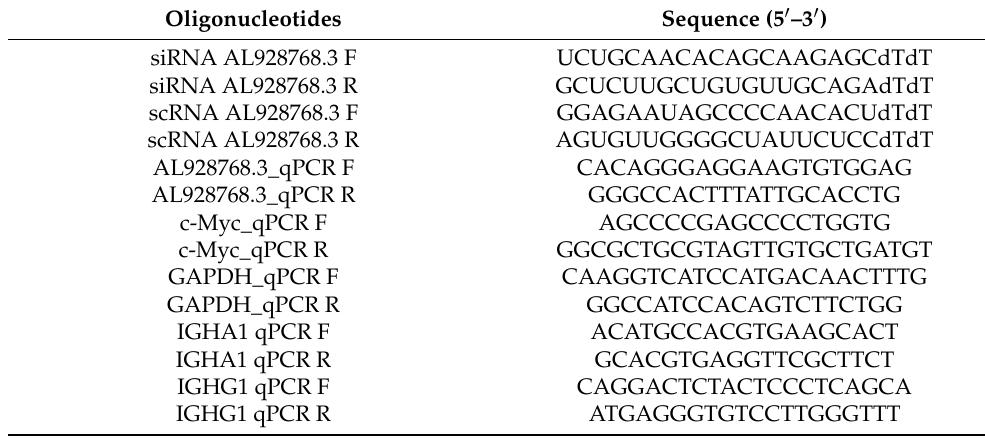
Table 1. Oligonucleotide sequences for sequence-specific siRNA and primers for qPCR. Oligonucleotides Sequence (5 (cid:48) –3 (cid:48)